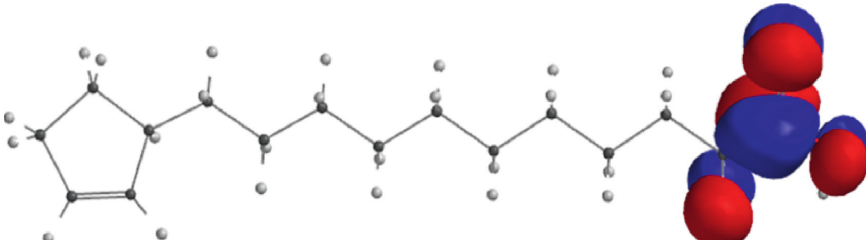
Figure 11: LUMO map of chaulmoogric acid.